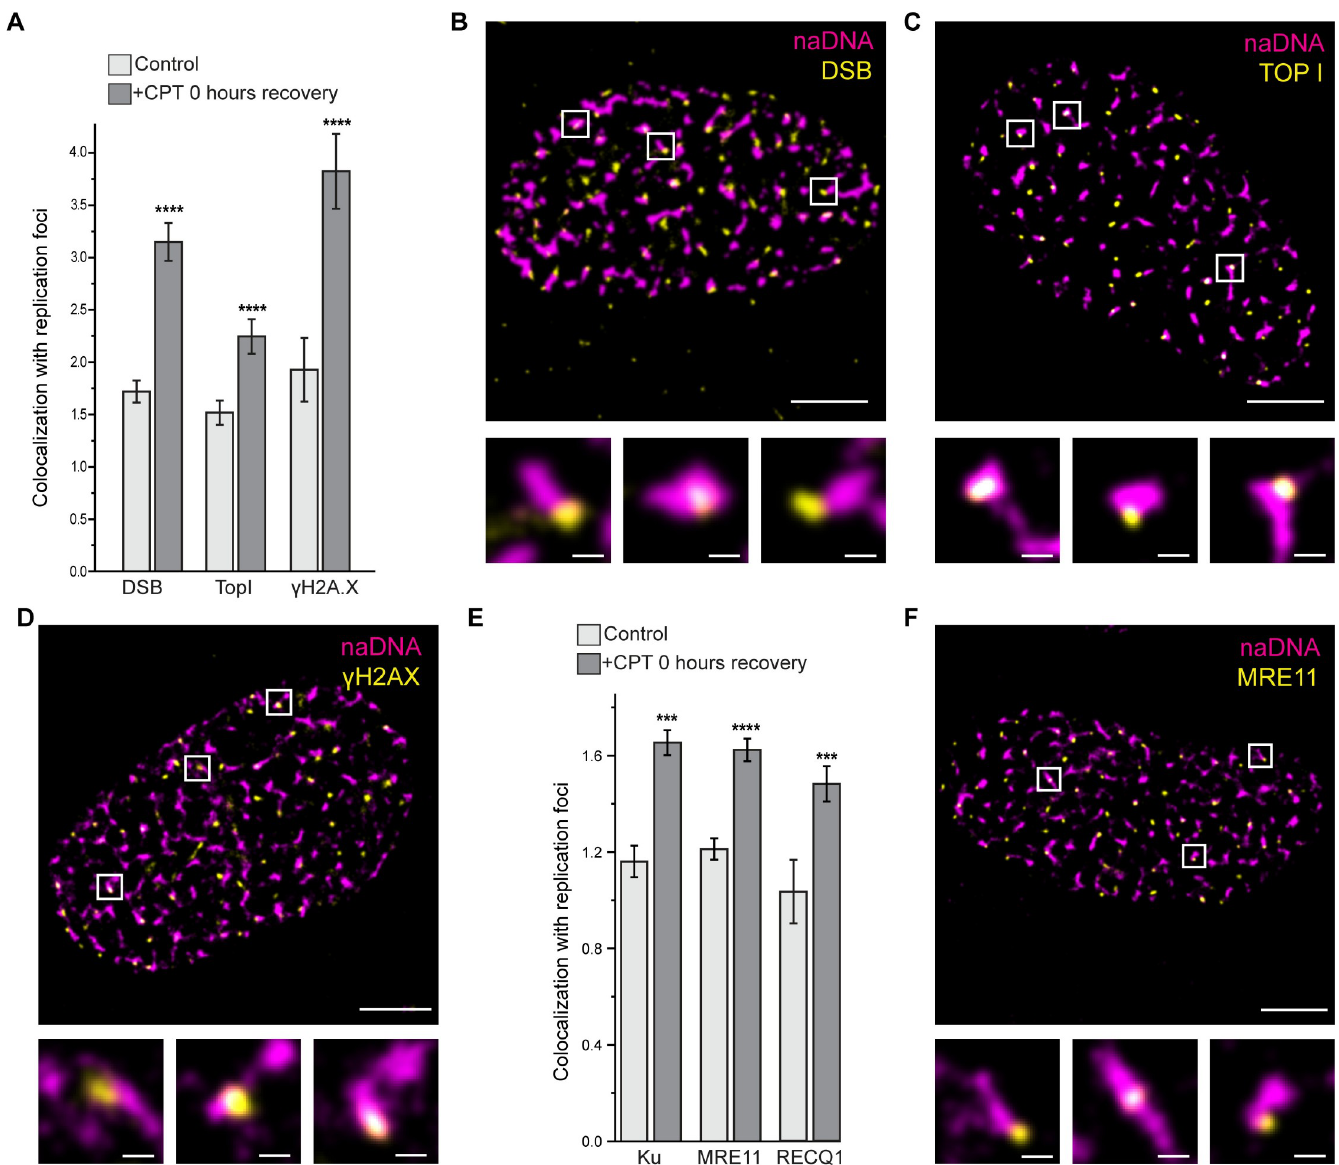
Fig 2. Both fork protection and HR repair proteins colocalize with replication foci following CPT-induced damage. (A) Quantification of colocalization of EdU labelled replication foci (naDNA) with DSBs (via TUNEL labelling), TopI, and γ H2AX in undamaged and CPT-damaged cells. (B) Representative SR image of a single nucleus damaged with 100 nM CPT and labelled for naDNA (magenta) and DSBs (using TUNEL)(yellow). Zoomed in regions show colocalization. Representative undamaged whole-cell image shown in S7A Fig. (C) Representative SR image of a single nucleus damaged with 100 nM CPT and labelled for naDNA (magenta) and TopI (yellow). Zoomed in regions show colocalization. Representative undamaged whole-cell image shown in S7B Fig. (D) Representative SR image of a single nucleus damaged with 100 nM CPT and labelled for naDNA (magenta) and γ H2AX (yellow). Zoomed in regions show colocalization. Representative undamaged whole-cell image shown in S7C Fig. (E) Quantification of colocalization of replication foci (naDNA) with Ku, MRE11, and RECQ1 in undamaged and CPT-damaged cells. Representative whole-cell control and CPT-treated cells for naDNA/Ku and naDNA/RECQ1 labelling shown in S7E–S7H Fig. (F) Representative SR image of a single nucleus damaged with 100 nM CPT and labelled for naDNA (magenta) and MRE11 (yellow). Zoomed in regions show colocalization. Representative undamaged whole-cell image shown in S7D Fig. Complete N values available in S1 Table, number of replicates > 3, number of cells imaged typically 20–60. All graphs show mean ± s.e.m. Student’s t-test results shown for comparison with control levels: ��� depicts p < 0.001, ���� depicts p < 0.0001. Scale bars = 3 μ m in whole cell images, 250 nm in zoomed sections.